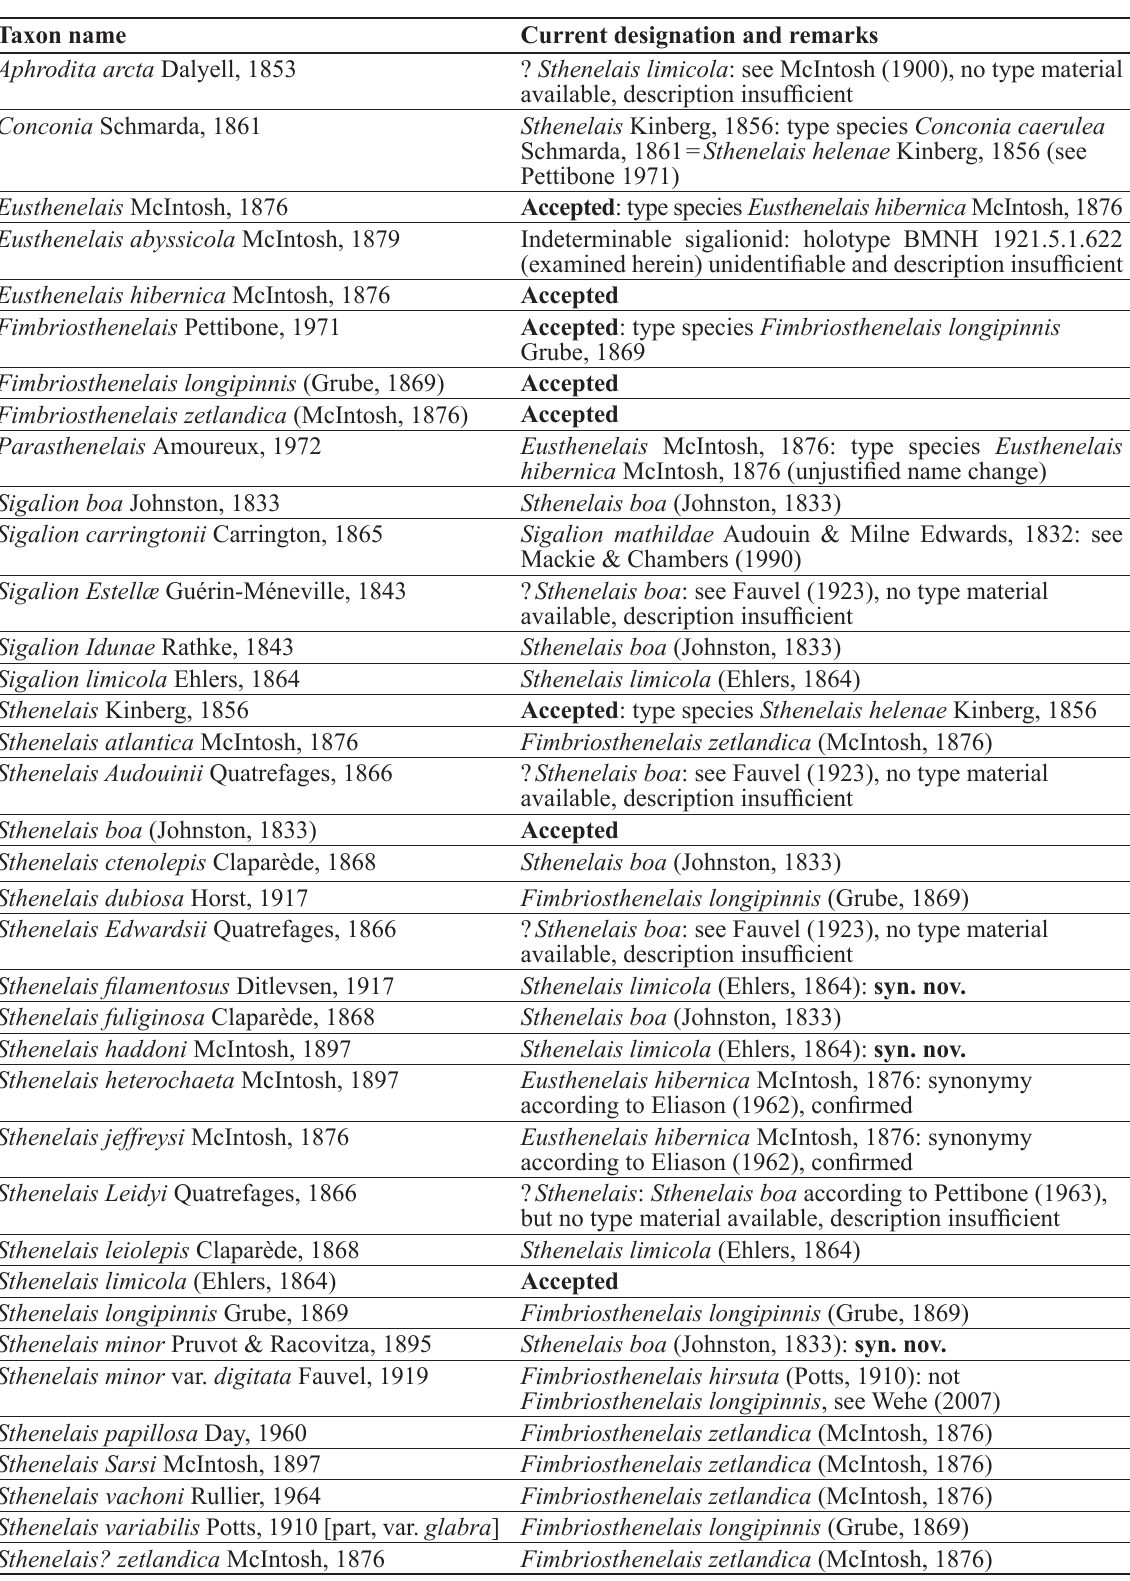
Table 2. Status of all nominal taxa attributed to Sthenelais Kinberg, 1856, Fimbriosthenelais Pettibone, 1971 and Eusthenelais McIntosh, 1876 in the Northeast Atlantic and Mediterranean